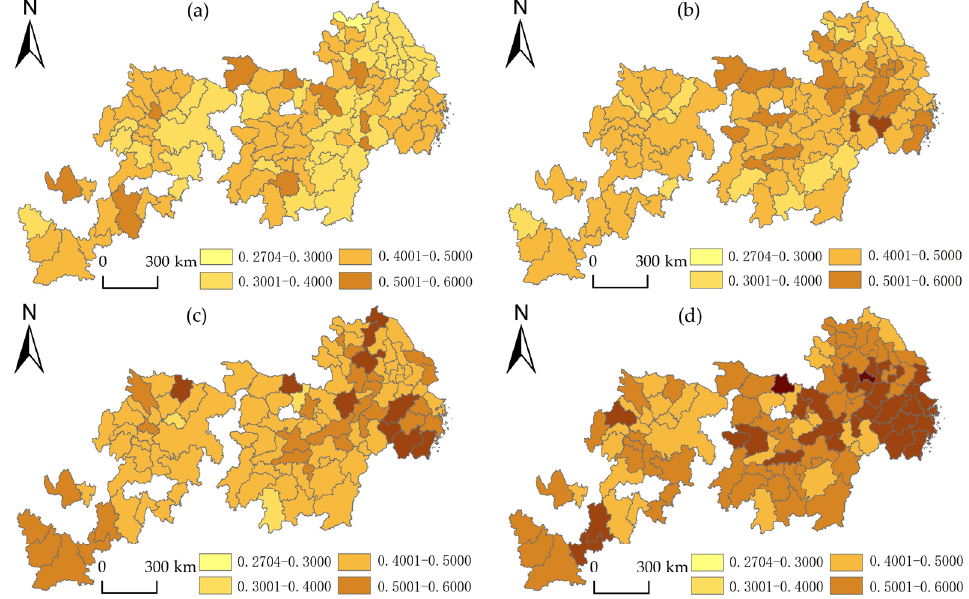
Figure 6. Spatial differentiation of coupling coordination between industrial integration and ULUE. ( a ) The coupling coordination degree in 2005; ( b ) the coupling coordination degree in 2009; ( c ) the coupling coordination degree in 2014; ( d ) the coupling coordination degree in 2019.